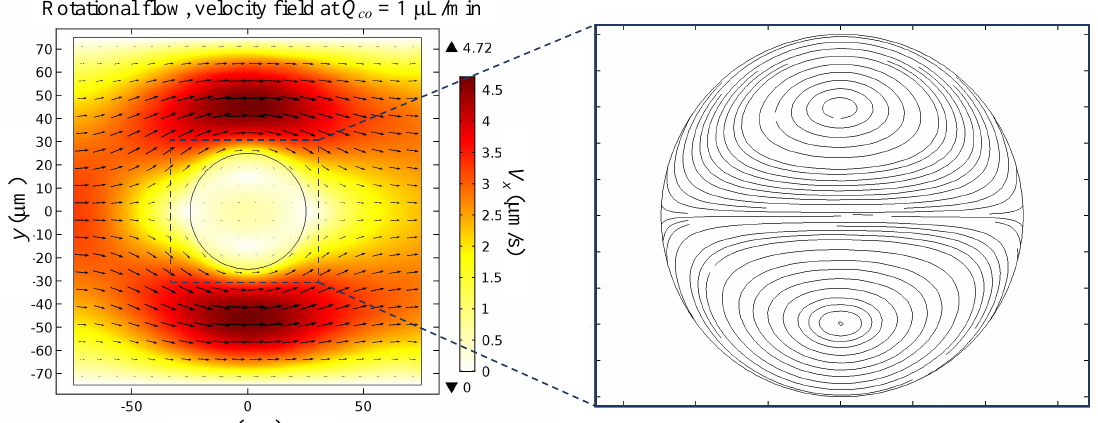
Figure 2. External flow field inside and outside a droplet at Q co = 1 µL/min due to the 4.5 mm/s velocity difference between the droplet and the external fluid.